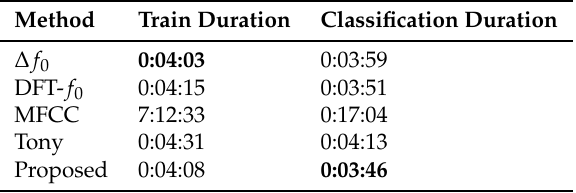
Table 7. Computation times for training and classifying in the Bertsolaritza